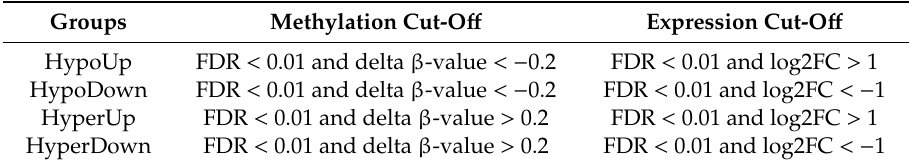
Table 1. Di ff erentially methylated and expressed genes (DMEGs) grouping